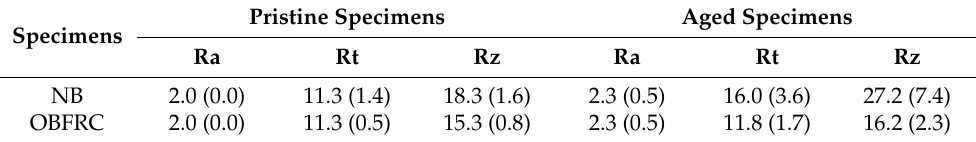
Table 1. Roughness parameters for NB and OBFRC surfaces before and after UV irradiation. Pristine Specimens Aged Specimens